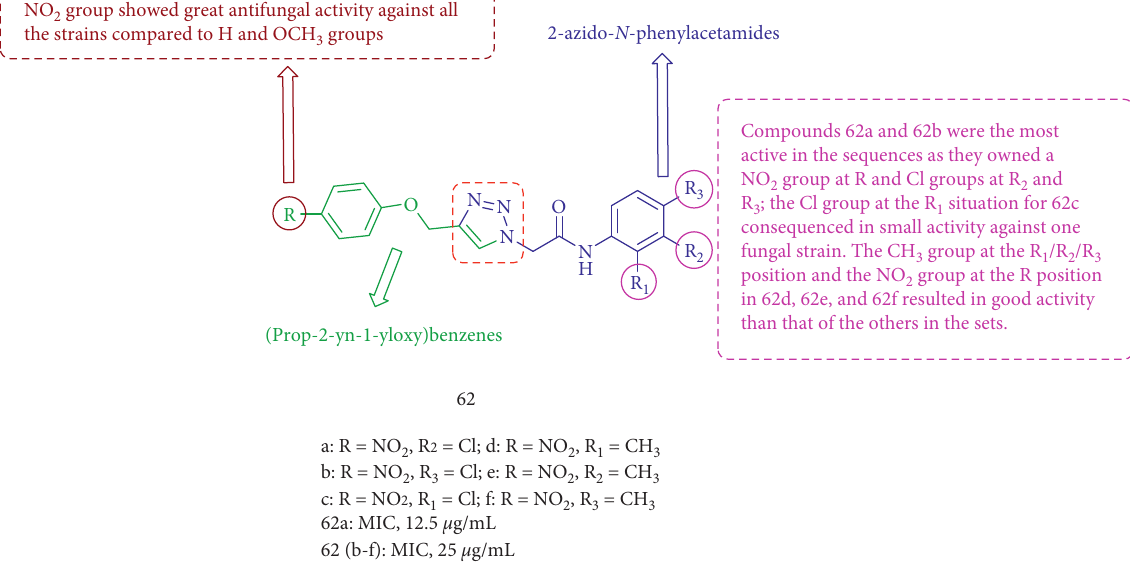
Figure 18: Chemical structure of new N-phenylacetamide-incorporated 1,2,3-triazoles.